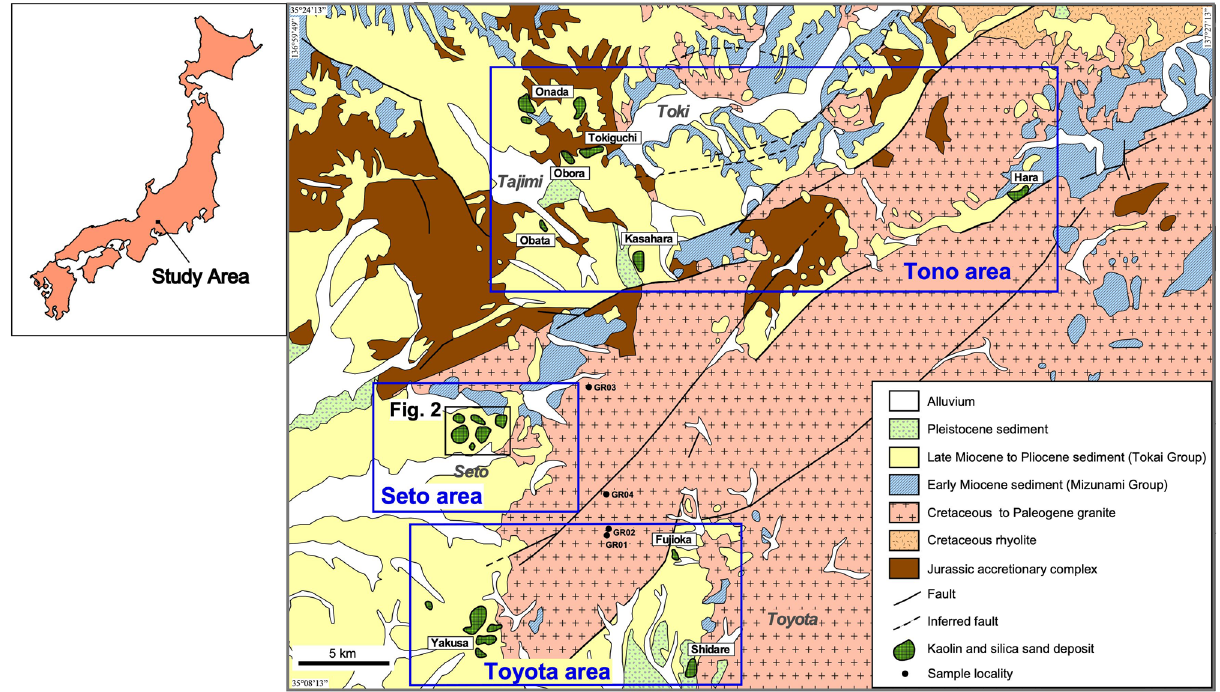
Figure 1. Geologic map of Seto-Tono district after Ref. 6 , distribution of kaolin and silica sand deposits and sample localities of basement